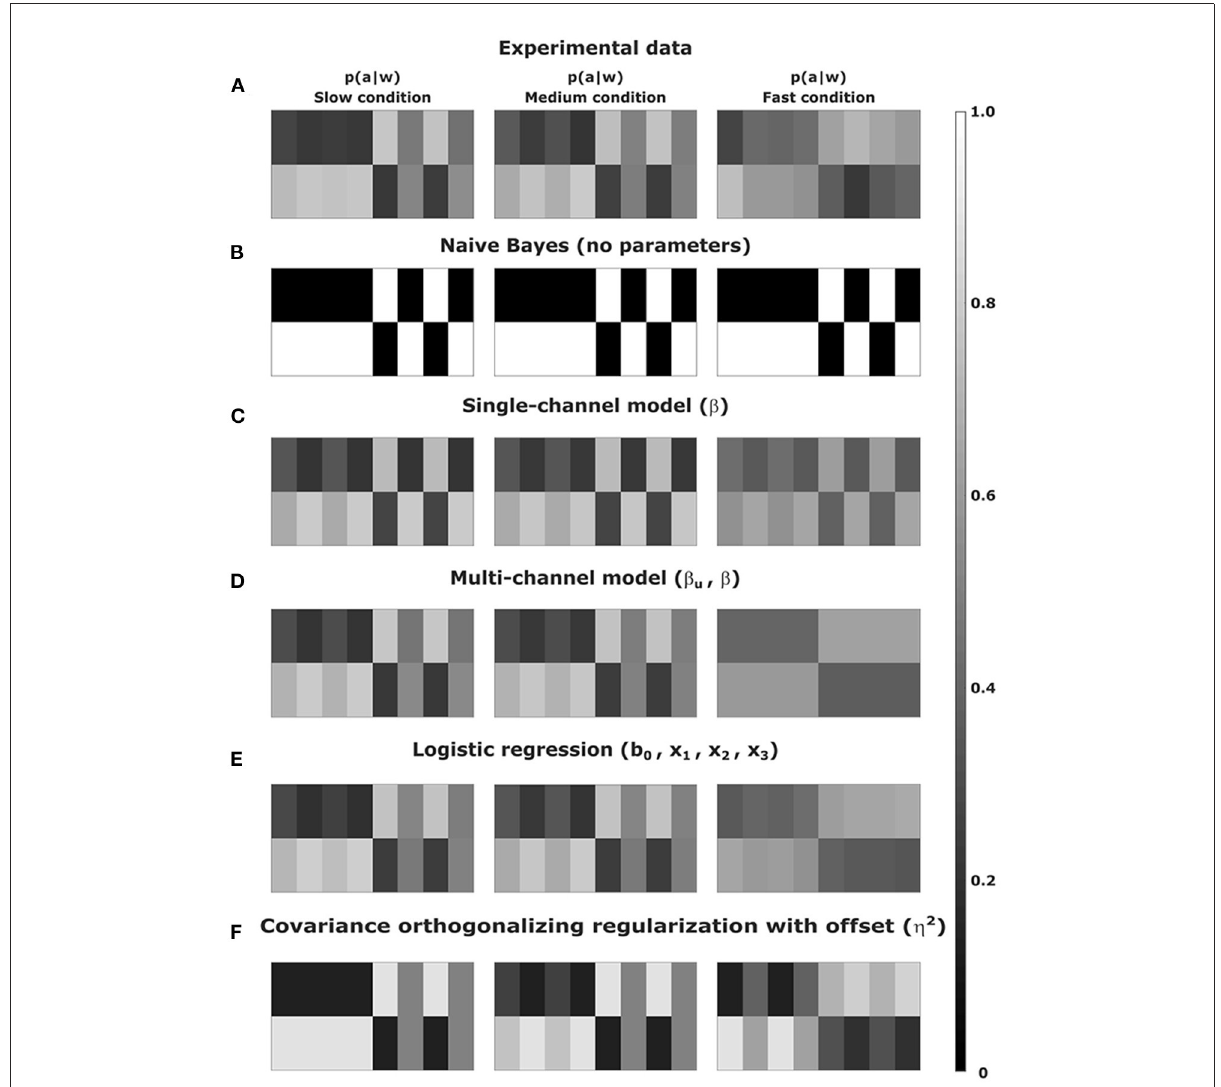
FIGURE8 Averaged selection strategies recorded experimentally (A) and compared to averaged theoretical selection strategies predicted by a naive Bayes-optimal model (B) , a single information channel model (C) and a bounded rational model with multiple feature-specific information channels (D) , a logistic regression (E) , and the bounded rational regression model (F) by Parpart et al. (2018).